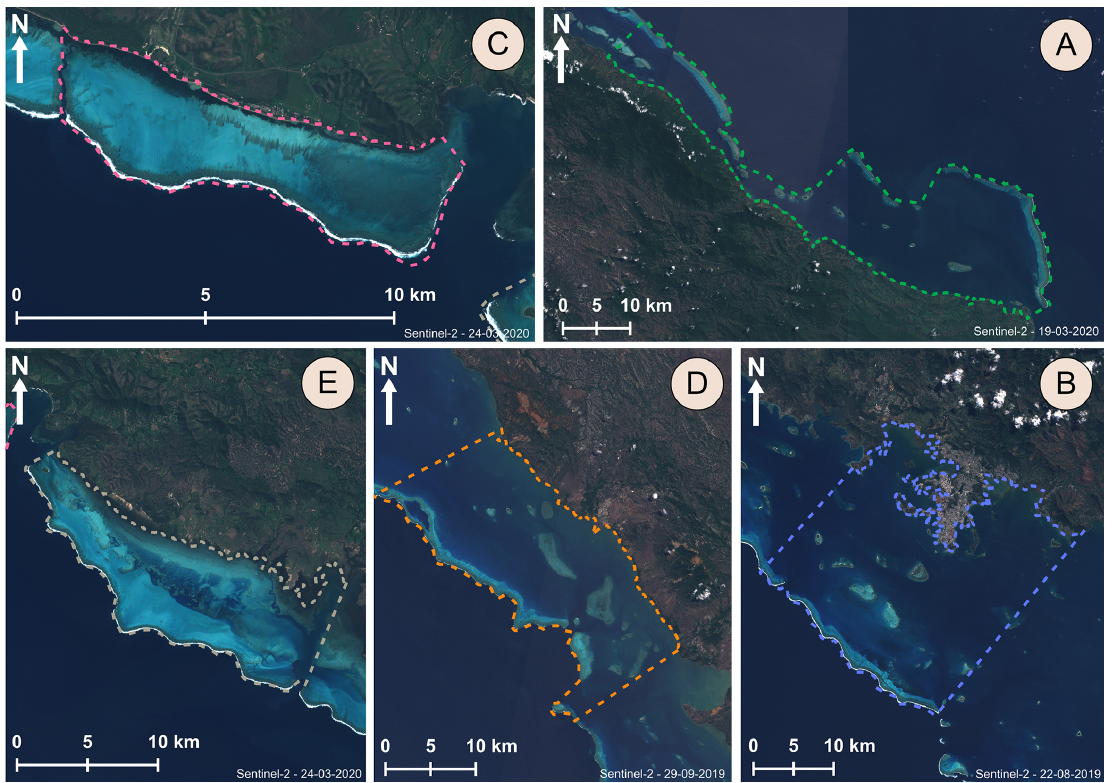
Figure 2. Geomorphologies of the lagoons from Sentinel-2 imagery from European Space Agency (ESA): (a) Hienghène–Touho lagoon, (b) SW lagoon (Nouméa), (c) Poé lagoon, (d) Koumac lagoon, and (e) Moindou